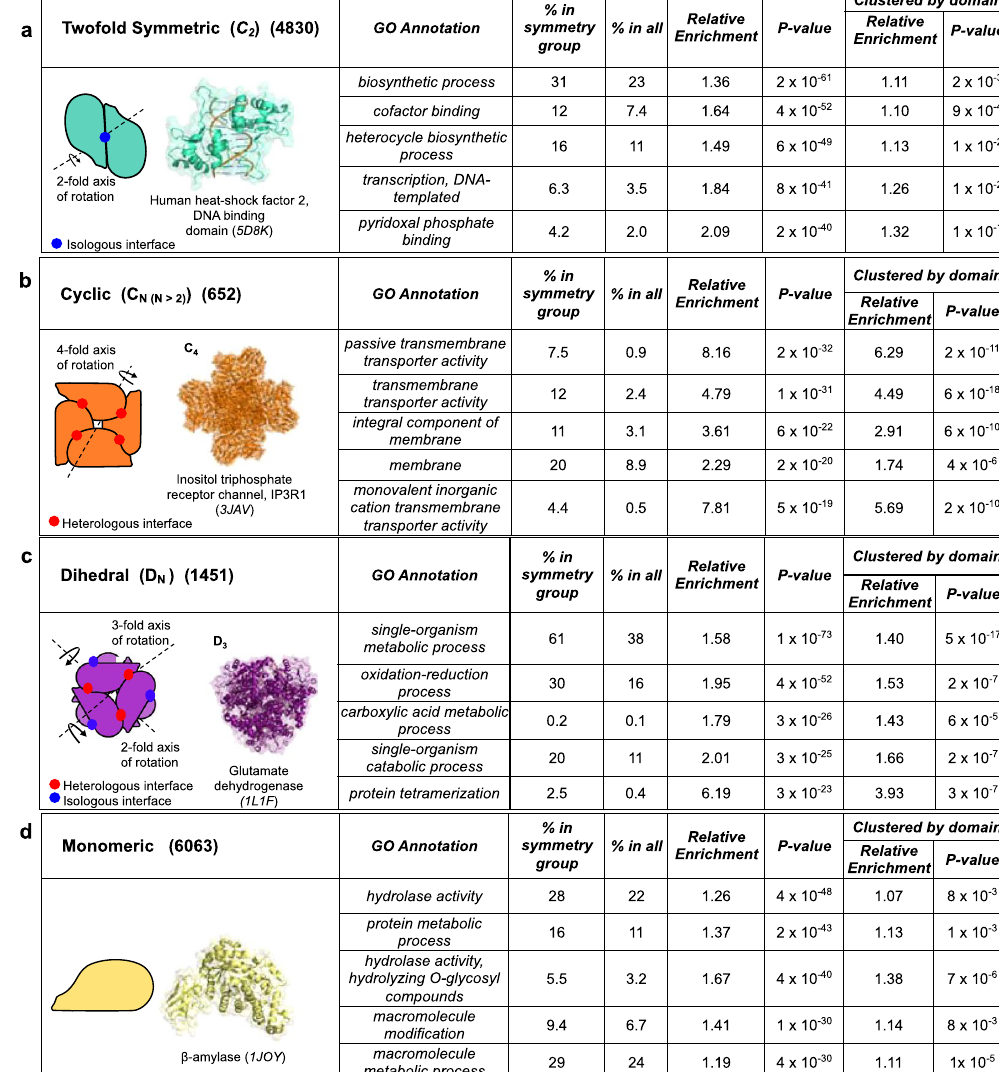
Our dataset has 4830 non-redundant C 2 structures, making it by far the most commonly observed symmetry group, comprising 66.3% of homomers. This mirrors previous studies, where small complexes with even numbers of subunits have been found to be much more common in the PDB than larger complexes with odd numbers of subunits 6, 35 . An early hypothesis by Monod et al . suggested that an isologous interface is more likely to evolve from a random mutation, as each amino acid occurs twice 36 . It has however since been shown that this effect is